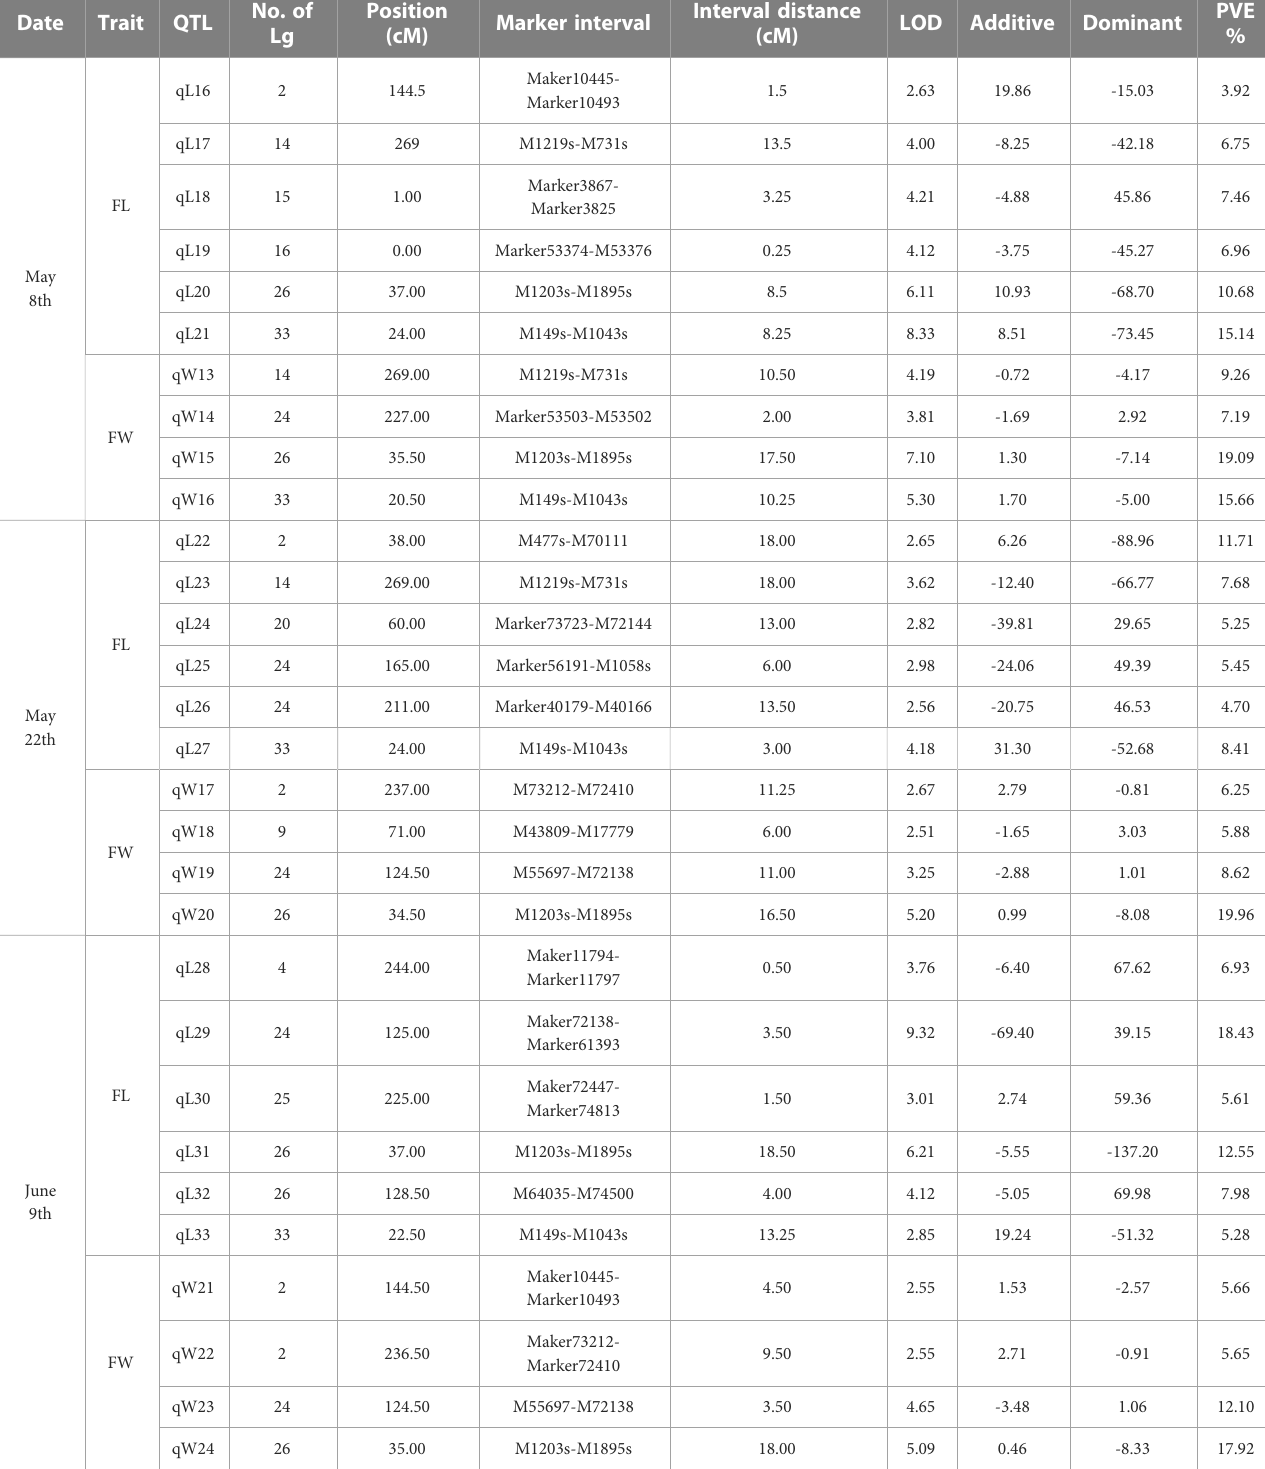
TABLE 4 QTLs detected for blade length (FL) and width (FW) in S.japonica on three observation days with integrated genetic linkage map using the ICIM method in QTL IciMapping. Date Trait Marker interval